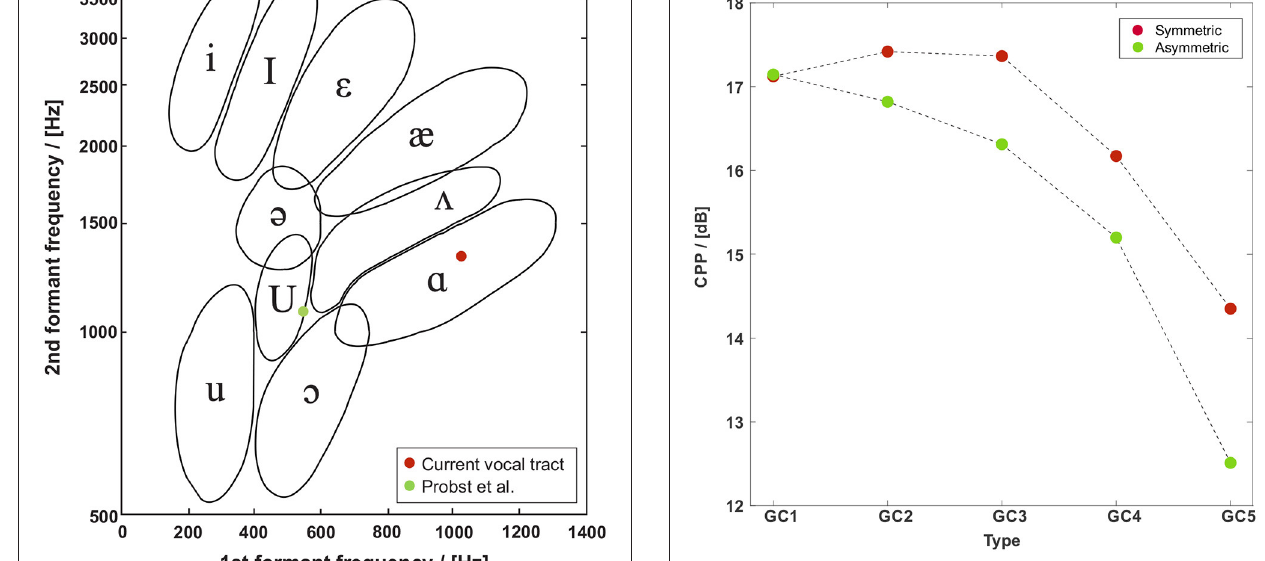
FIGURE 10 | Formant chart as proposed by Peterson and Barney (1952), shows the formant frequencies of the first two formants found in this study and that of Probst et al. (2019). In contrast to Probst et al. (2019), F 1 = 1,020 Hz and F 2 = 1,350 Hz simulated by simVoice are well-positioned within the region of the /a/ vowel.